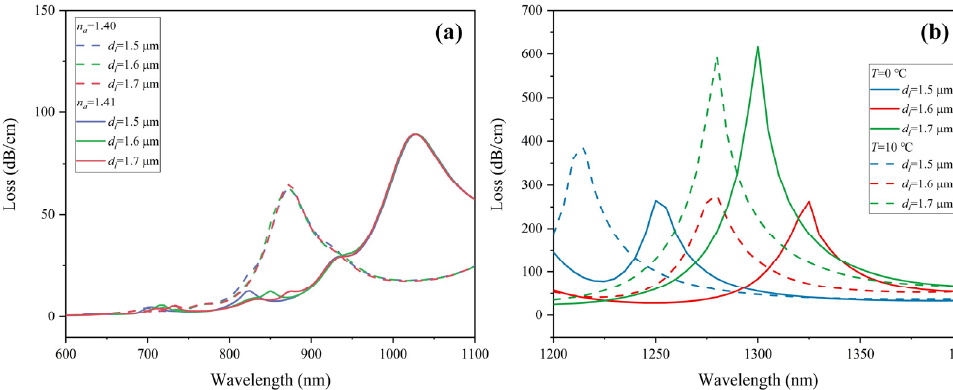
Figure 11. Loss spectra of ( a ) y- polarization core mode in RI sensing channel when analyte RI varies from 1.40 to 1.41, and ( b ) x- polarization core mode in temperature sensing channel under ambient temperature from 0 to 10 °C with different diameter of air holes d l . Table 1. Performance comparison between the proposed sensor and previously reported